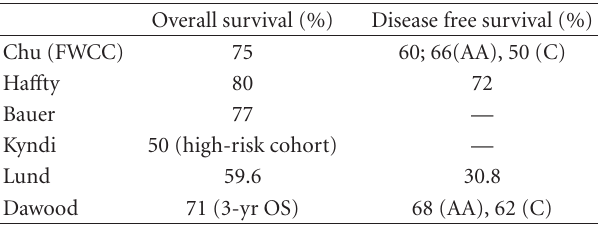
Table 4: Comparison of clinical outcomes for patients with triple- receptor negative breast